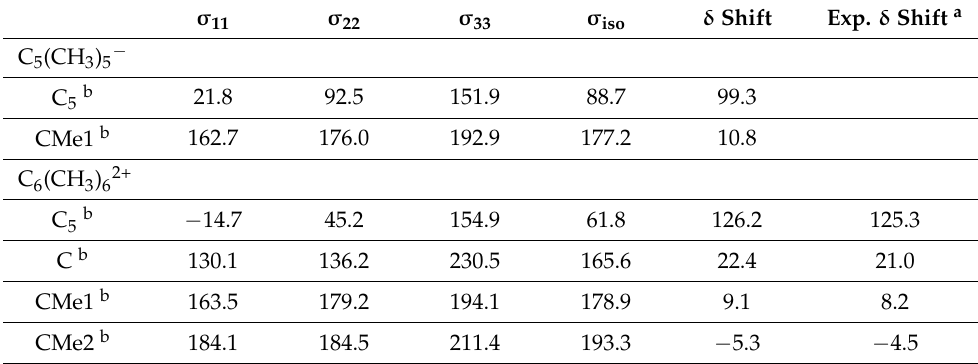
Figure 2. Formation of the electronic structure in terms denoting the combination of the set of π orbitals from [C 5 (CH 3 ) 5 ] – and CCH 33+ leading to the formation of both σ and π bonds. The 13 C-NMR spectra depicted by Malischewski and Seppelt [13] show a peak at 125.5 ppm accounting for the C 5 ring atoms and at 8.2 ppm for the attached methyl groups, leaving signals at 21.0 ppm for the carbocation atom and at − 4.5 ppm for the CCH 3 methyl group. The calculated (calc.) values are in agreement with the experimental (exp.) data (Table 1). Such values were compared to the calculated values for the isolated C 5 (CH 3 ) 5 − ring, with values of 99.3 ppm for C 5 ring atoms and 10.8 ppm for attached methyl groups, denoting that the latter groups remain similar upon the inclusion of the CCH 3 carbocation fragment, with a slight shielding (upfield) shift to 9.1 ppm. Ring atoms, in contrast, are consequently more affected, showing a deshielding (downfield) shift to 126.2 ppm (calc.) (125.3 ppm exp.) upon the formation of the pentagonal-pyramidal motif. For the carbocation atom and its attached methyl group, values amounting to 22.4 and − 5.3 ppm were calculated, respectively. Table 1. Calculated CSA parameters for different carbon atoms at C 5 (CH 3 ) 5 − and C 6 (CH 3 ) 62+ , accounting for the 13 C-NMR spectra. Values in